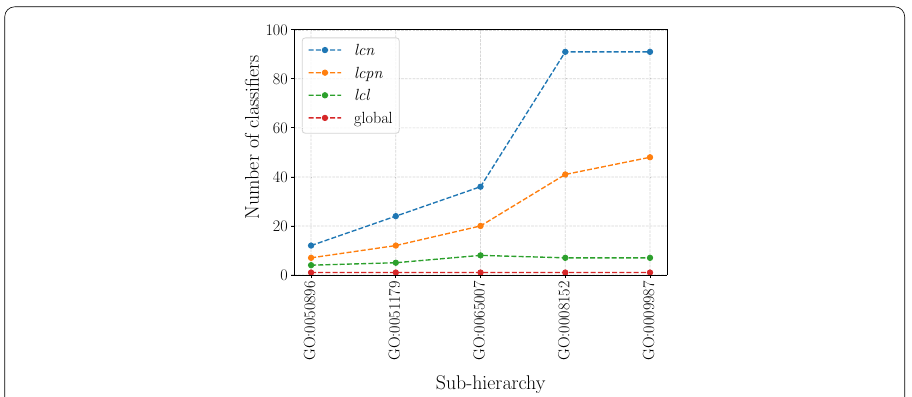
Fig. 5 Number of classifiers trained per HMC method and sub-hierarchy. The lcn requires | A ′ | − 1 classifiers. The lcpn requires as many classifiers as functions with children in H ′ . The lcl requires as many classifiers as the number of levels in H ′ . At last, the global method requires one classifier per